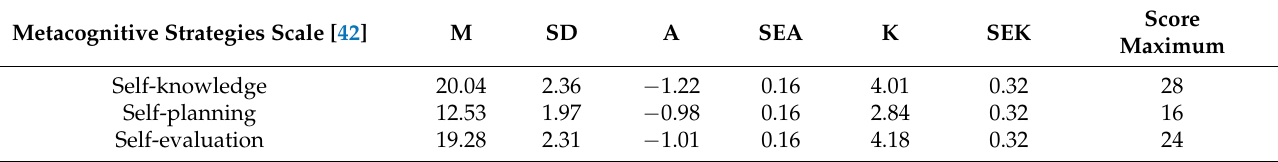
Table 2. Descriptive statistics and analysis of skewness and kurtosis in the Metacognitive Strategies Scale [42]. Metacognitive Strategies Scale [42]